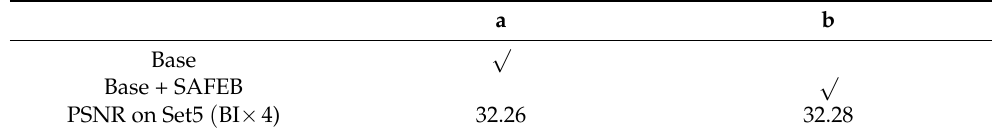
Table 5. Ablation analysis of SAFEB.